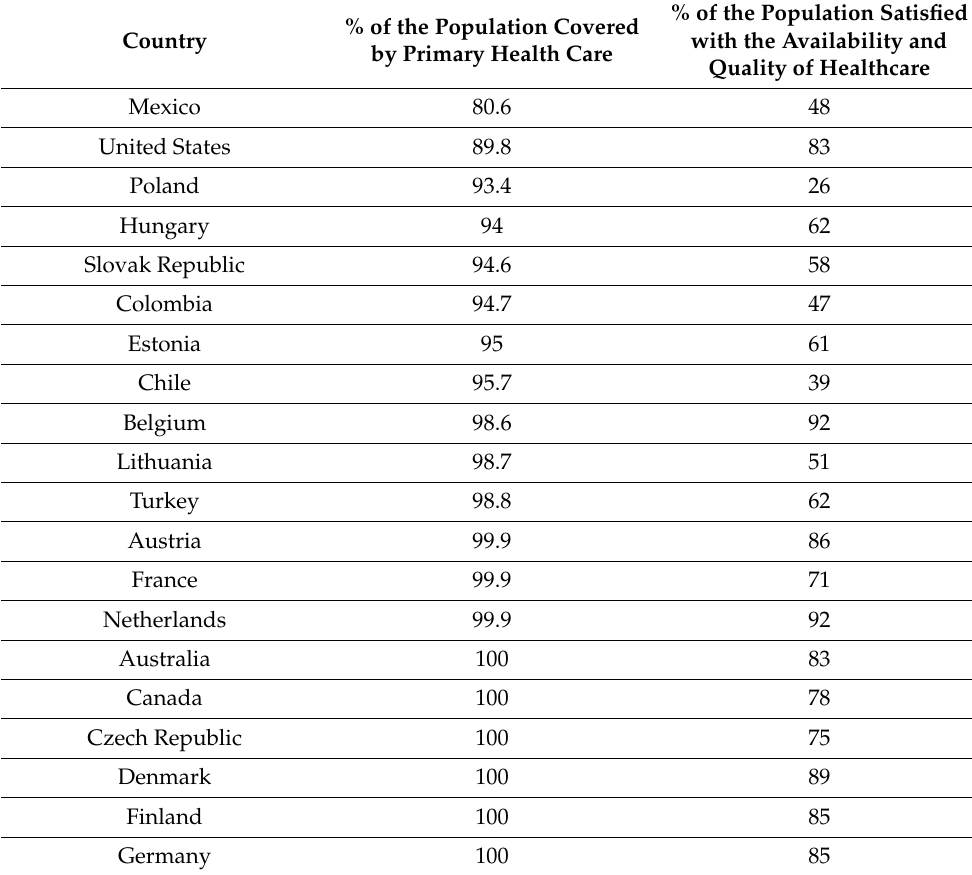
Table 3. Percentage of residents covered by primary health care and satisfied with the quality and availability of the health care in selected OECD countries in 2019 [23]. % of the Population Country